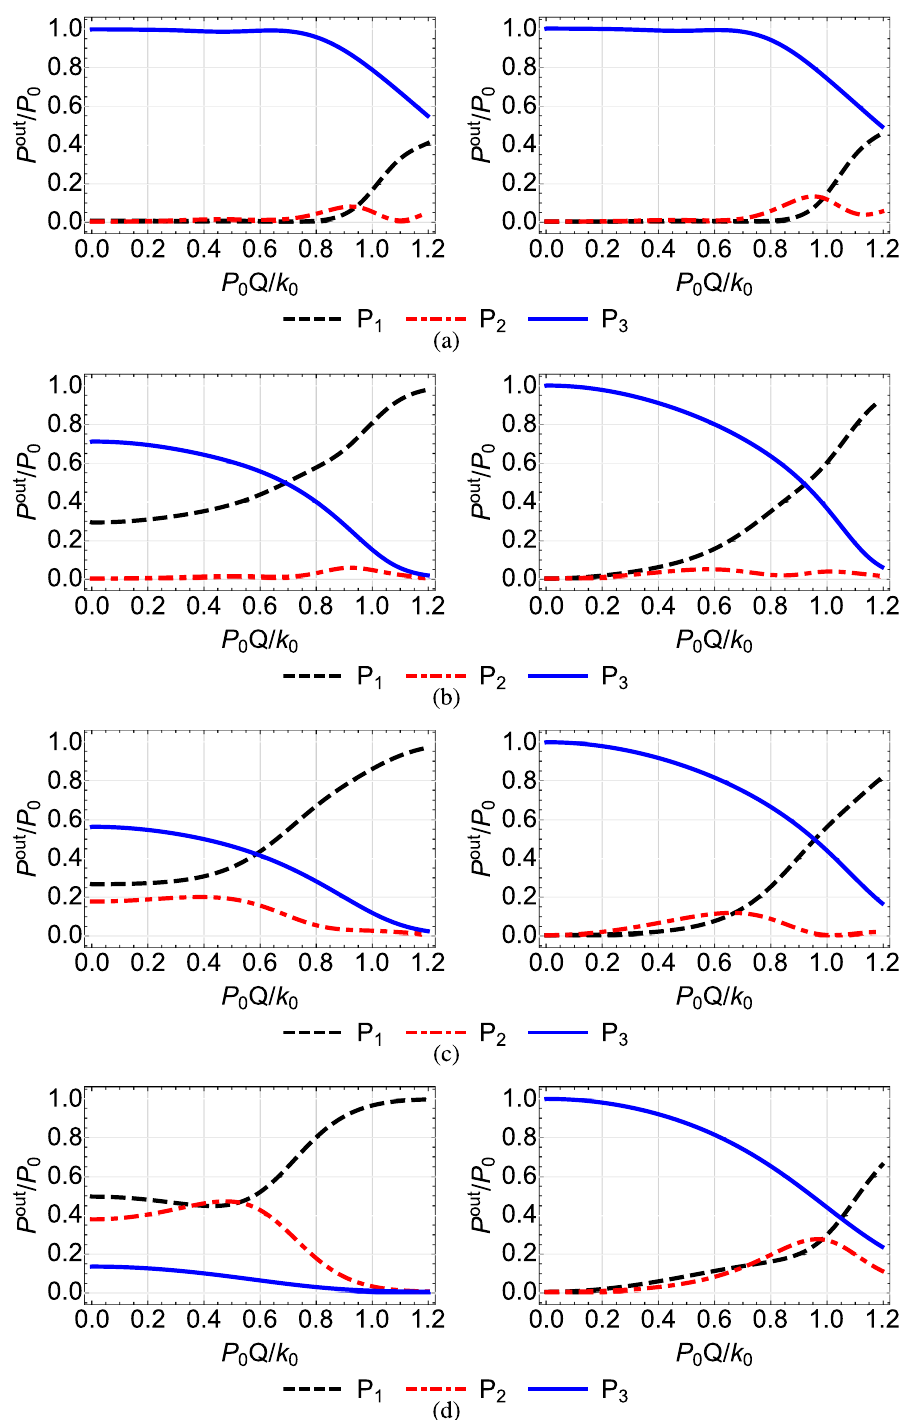
out P P i ( Z )/ P 0 0 at each waveguide as a function of the normalized i / = Q , Q 0, Q 3 0 , for the Gaussian (left column) and modified shortcut (right 2 = = =